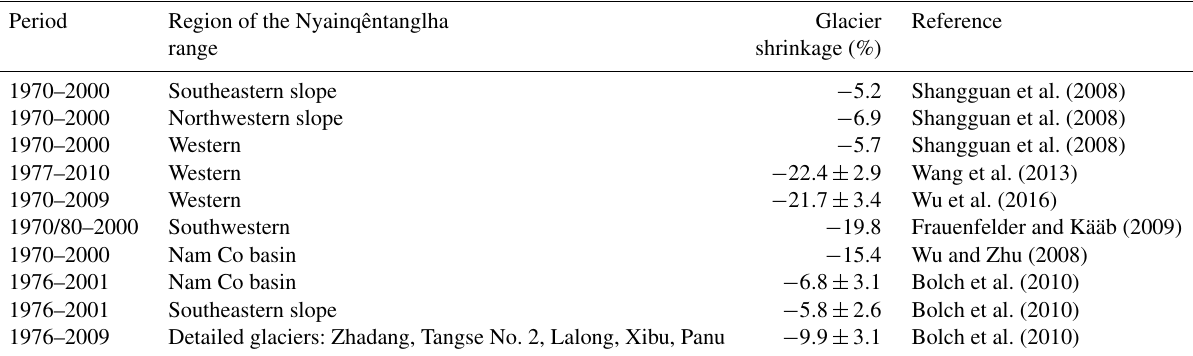
Table 2. Overview of glacier area changes (%) in the western Nyainqêntanglha range (changed after Wu et al., 2016). Period